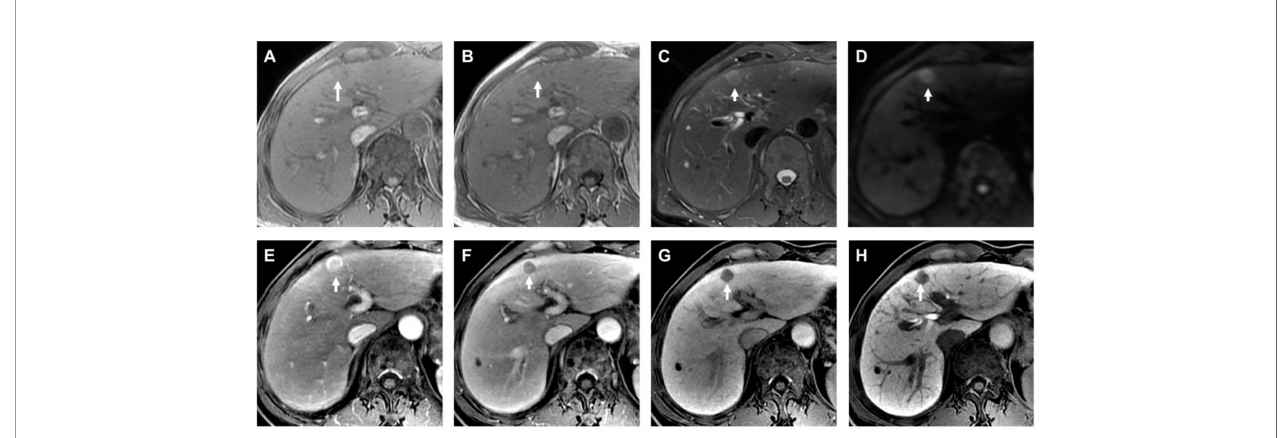
FIGURE 2 | Histopathological con fi rmed HCC with the size of 1.2 cm. The HBSC-MRI showed an isointense nodule in T1-weighted images in-phase [arrow in (A) ] and out-phase [arrow in (B) ] in liver segment IV. This focal liver lesion demonstrated slightly hyperintensity in the T2-weighted image [arrow in (C) ], and with diffusion restriction [arrow in (D) ]. The nodule showed typically imaging feature of “ wash-in ” in the arterial phase (E) , and “ wash-out ” in the portal venous phase (F) . The transitional phase [arrow in (G) ] and hepatobiliary phase [arrow in (H) ] clearly showed the nodule hypointensity. The fi nal MRI diagnosis was a HCC, con fi rmed by histology after